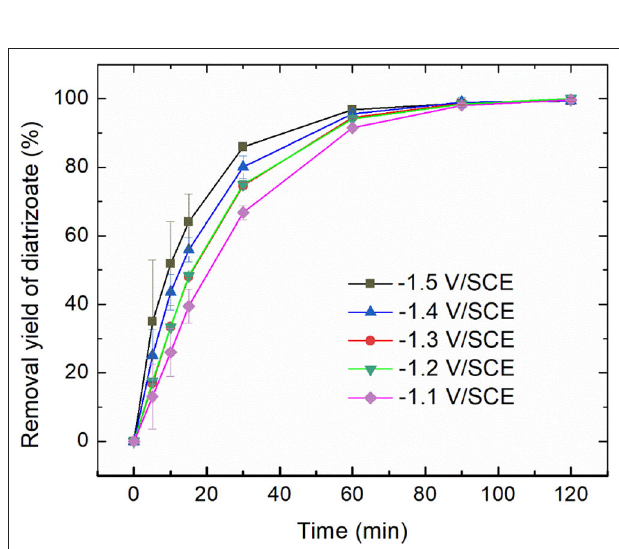
FIGURE 3 | Removal yield of diatrizoate (100mg L − 1 in 0.1mol L − 1 Na 2 SO 4 , 100mL) vs. time during electroreduction in the electrochemical flow cell (3mL min − 1 ). Error bars are based on duplicate experiments.